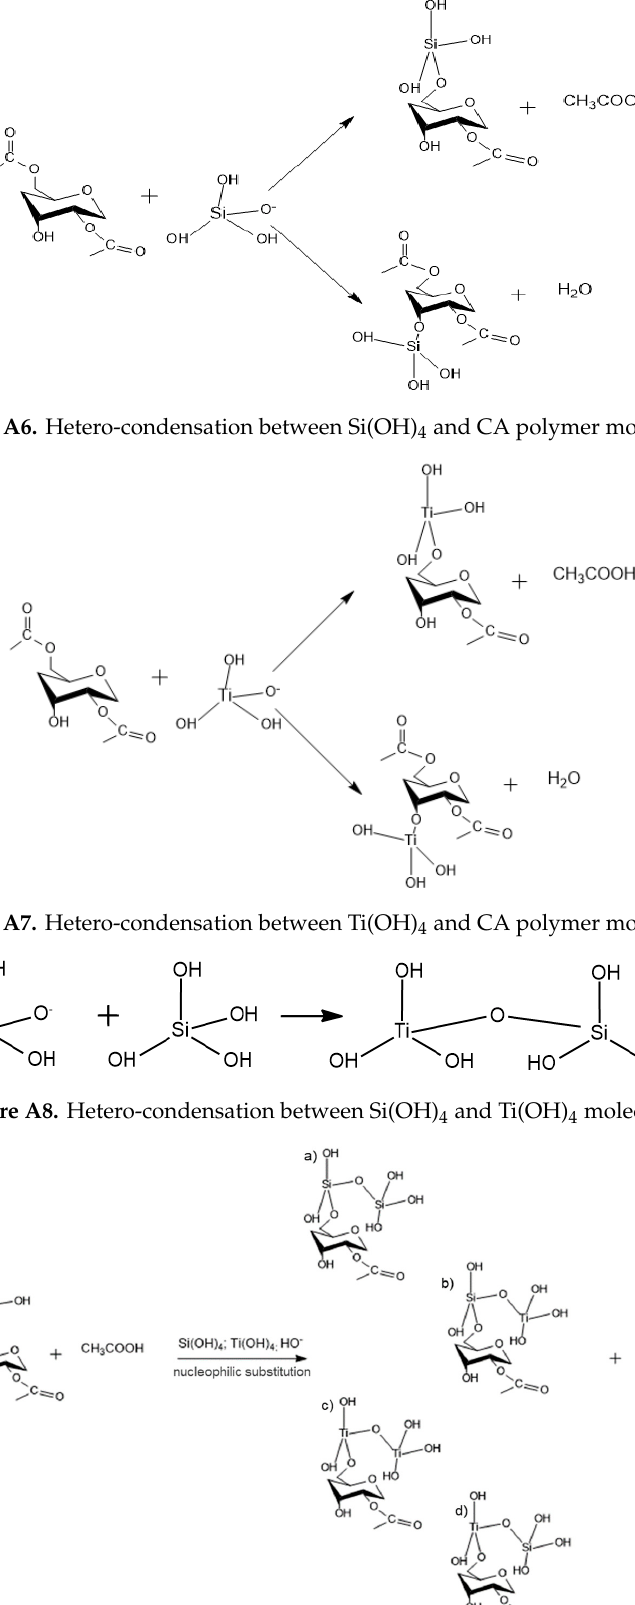
Figure A9. Further condensation reactions between Si(OH) 4 and/or Ti(OH) 4 molecules with other inorganic molecules already bonded to the CA polymer. Appendix B Calculation base: 100 g casting solution M (TEOS) = 208.33 gmol − 1 M(SiO 2 ) = 60.0843 gmol − 1 M(TiPOT) = 284.22 gmol − 1 M(TiO 2 ) = 79.8658 gmol − 1